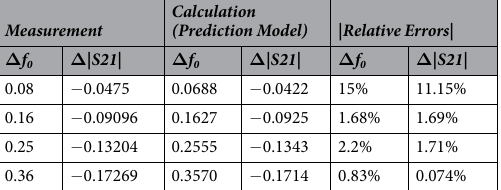
State 2 . The front tubes are set to parallel to x-axis. Figure 3 shows the reconfigurable transmission proper- ties of linear polarization (E ∥ y denotes y-polarization and E ∥ x denotes x-polarization) and circular polarization (LCP denotes Left Circular Polarization and RCP denotes Right Circular Polarization). Figure 3(a2,b2) show the variable transmissions of y-polarization and x-polarization respectively. Both of them reach the maximum firstly and then drop to the minimum. The differences between them are the former keep all the minimums at 2.78 GHz while the latter maintain all the maximums at 2.54 GHz, no matter what the volume ratios are. By increasing the volume ratio of ethanol, the transmission characteristics can be easily reconfigurable, realizing the increase of insertion loss and the bandwidth for incidence of different polarization waves. Figure 3(c2) shows the cross-polarization (LCP-RCP) transmissions are under 0.4 and co-polarization (LCP-LCP) transmissions achieve up to 0.78. It suggests that the metasurfaces have strong ability for circular polarization-conserving trans- mittances at required frequency. Simulated and measured magnitudes are compared in Fig. 3(d2) at 2.45 GHz and they are in good agreement. Transmissions of different incident polarized wave monotonously change with volume ratio respectively and the similar predictive model can be founded by the same way illustrated in State 1. State 3 . Likewise, the front tubes are set to parallel to x-axis. Figure 3(a3) shows transmissions of y-polarization stay at 0.98 below 2.5 GHz, then drop quickly and split due to transmission characteristics of dif- ferent permittivity. By tuning the mixture ratio, the metasurfaces can serve as tunable low-pass FSS (Frequency